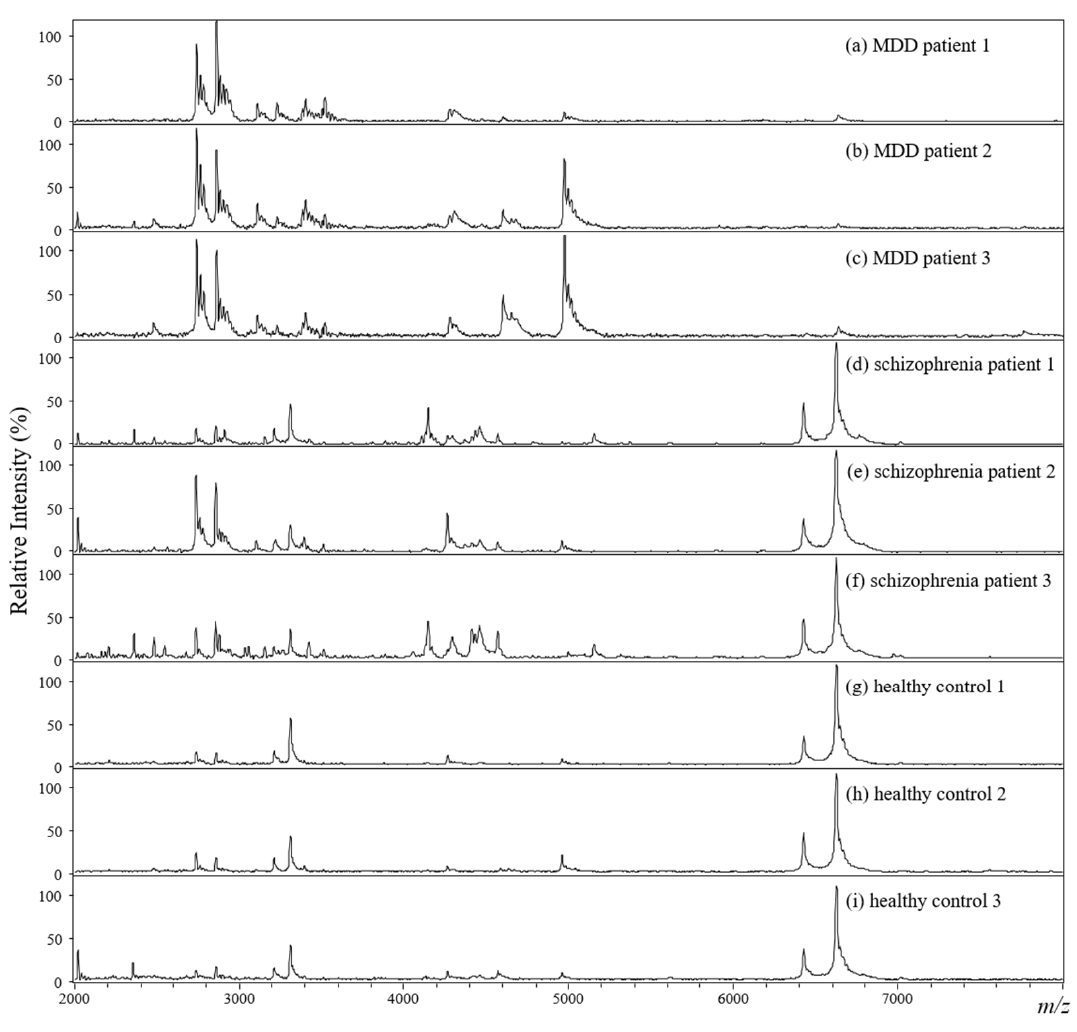
Figure 4. MALDI mass spectra of plasma samples from ( a – c ) MDD patients, ( d – f ) schizophrenia patients, and ( g – i ) healthy controls after hydrolysis with 25% TFA for 10 min and mixture with the α -CHC matrix (V sample :V matrix = 1:1).